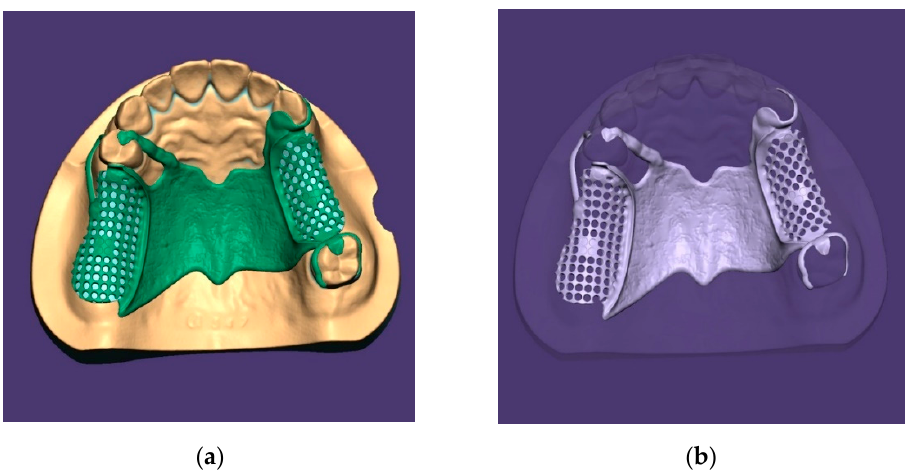
Figure 1. ( a ) Virtual waxing of the removable partial denture framework; ( b ) framework ready to export and three-dimensional printing.